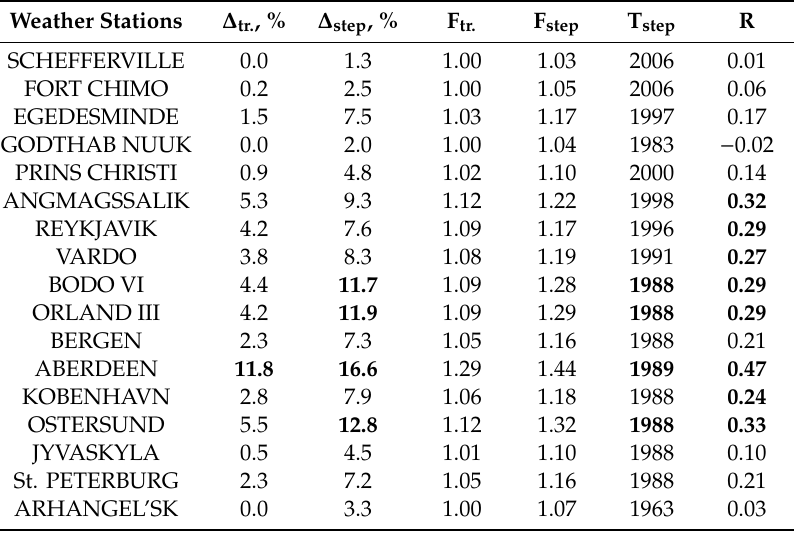
Table 2. The results of the e ffi ciency assessment of non-stationary models for the SAT time series at every weather station in January (1951–2016 period with the size of the time series n = 66). The bold font for ∆ tr. and ∆ step is used when the values are higher than or equal to 10%. The bold font for T step is used for the cases when ∆ step ≥ 10%. The bold font for R denotes statistically significant correlation coe ffi cients of linear trends for the whole